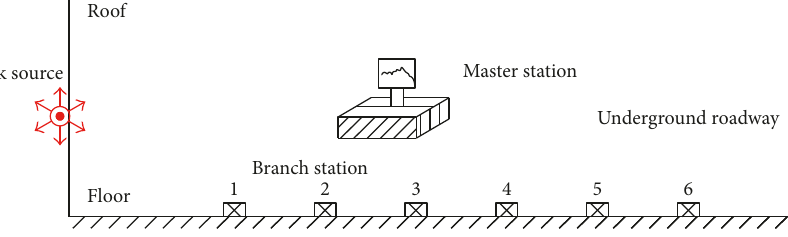
Figure 9: Test model of evaluation of shock wave